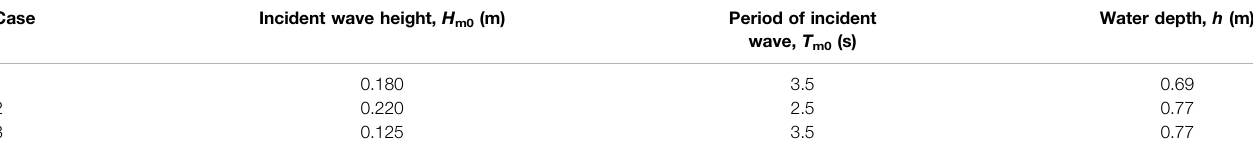
TABLE 1 | Parameters of the incident wave in test condition.